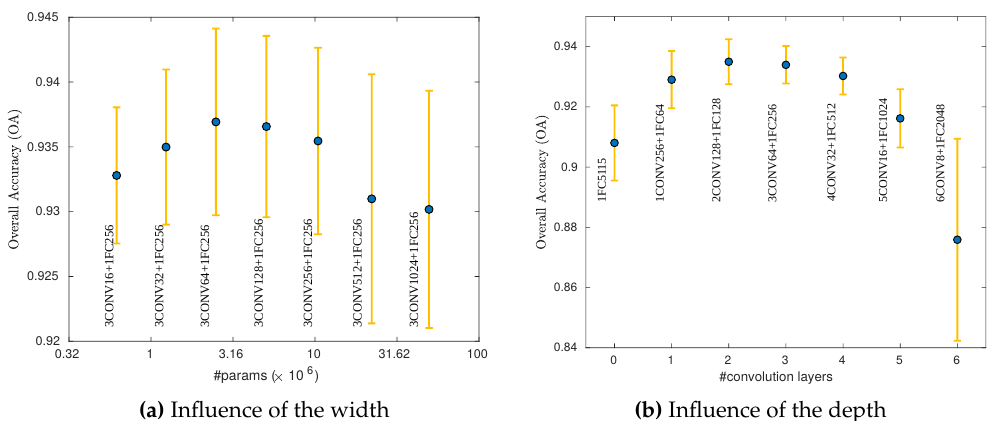
Figure 10. Overall Accuracy ( ± one standard deviation in orange) as a function of the number of parameters ( a ) or the number of successive convolutional layers ( b ) for seven temporal Convolutional Neural Network models. We use the dataset with three spectral bands and a regular temporal sampling at two